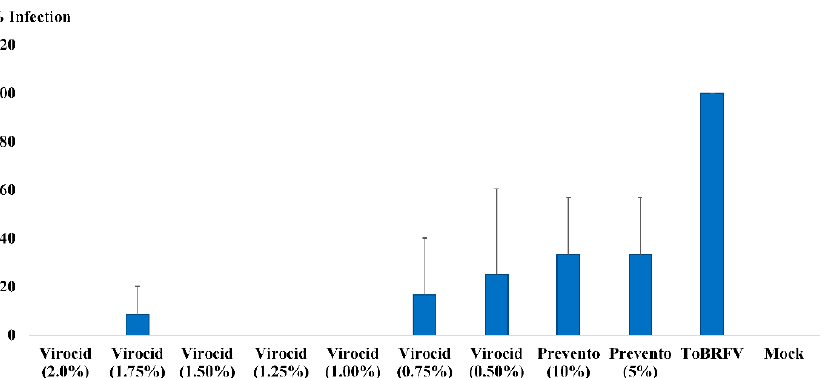
Figure 4. Average percent infections and standard deviations on test plants used for bioassays to assess efficacy of different concentrations of Virocid in a serial dilution (0.5% to 2%) against ToBRFV infectivity in two separate experiments. In addition, Prevento in 5% and 10% was also included in the test to show some partial effects against ToBRFV infectivity, whereas the positive control (ToBRFV) showed 100% infection and the Mock treatment with inoculation buffer had no infection.